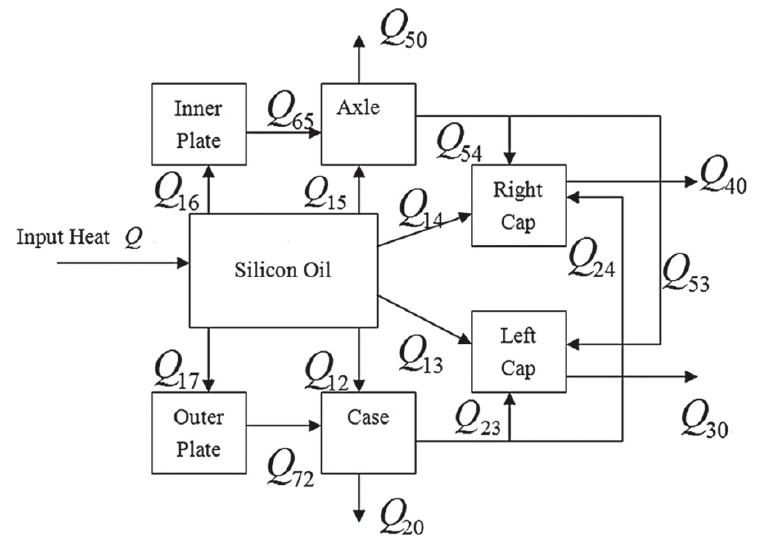
Figure 2. A simplified structure of a VC.